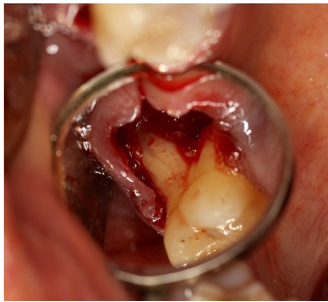
Figure 20. Furcation lesion between the distal buccal root and the palatal tooth 1.6 after 1.7 extraction. The alveolar cavity and roots were curetted and cleaned with a solution of physio- logical water and hydrogen peroxide 1:1 and collagen sponges, completely wetted by the blood from the surgical site, were applied and followed by the protective positioning of a shaped